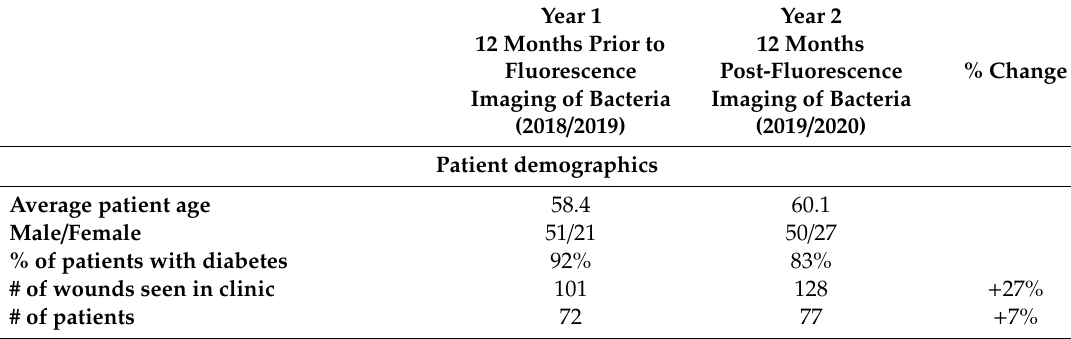
Table 2. Retrospective analysis of 12 months before (Year 1) and after (Year 2) implementing routine fluorescence imaging of bacteria into the podiatry clinic.